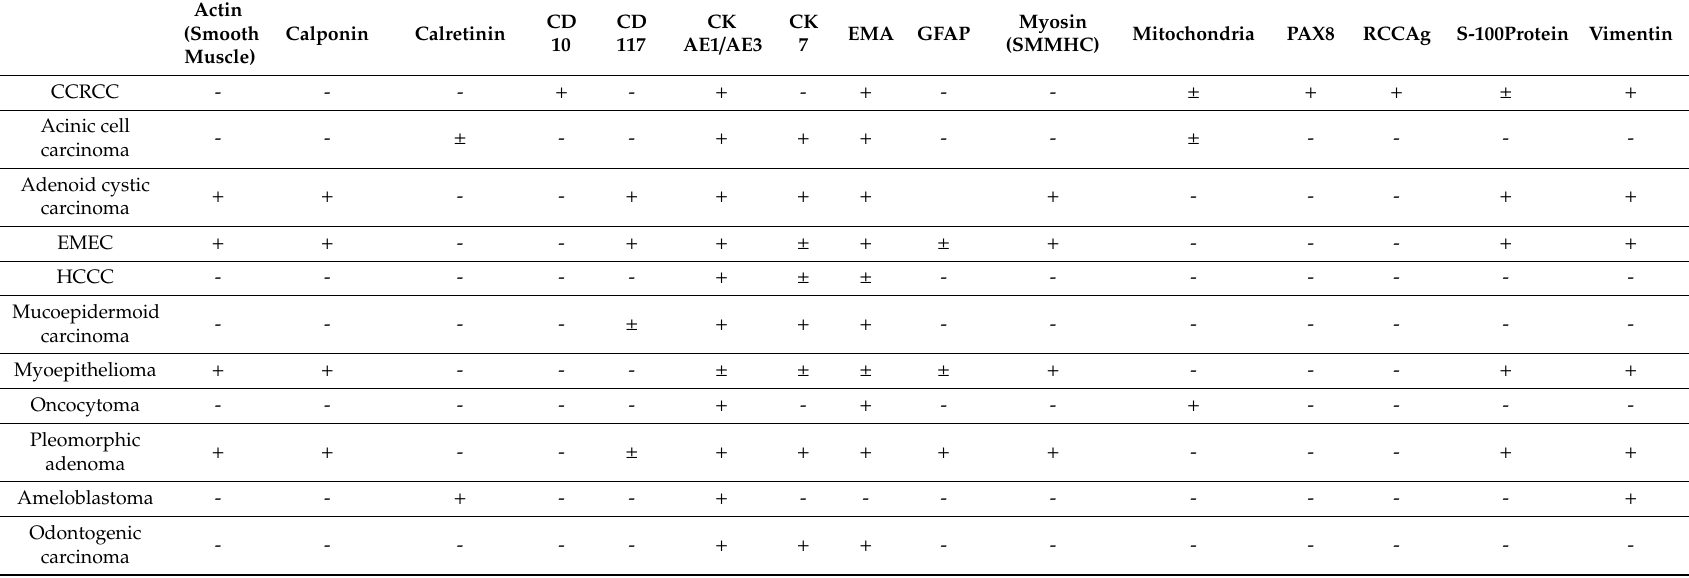
Table 3. Immunohistochemical profile of tumors with prominent clear cell features that most frequently a ff ect the oro-facial